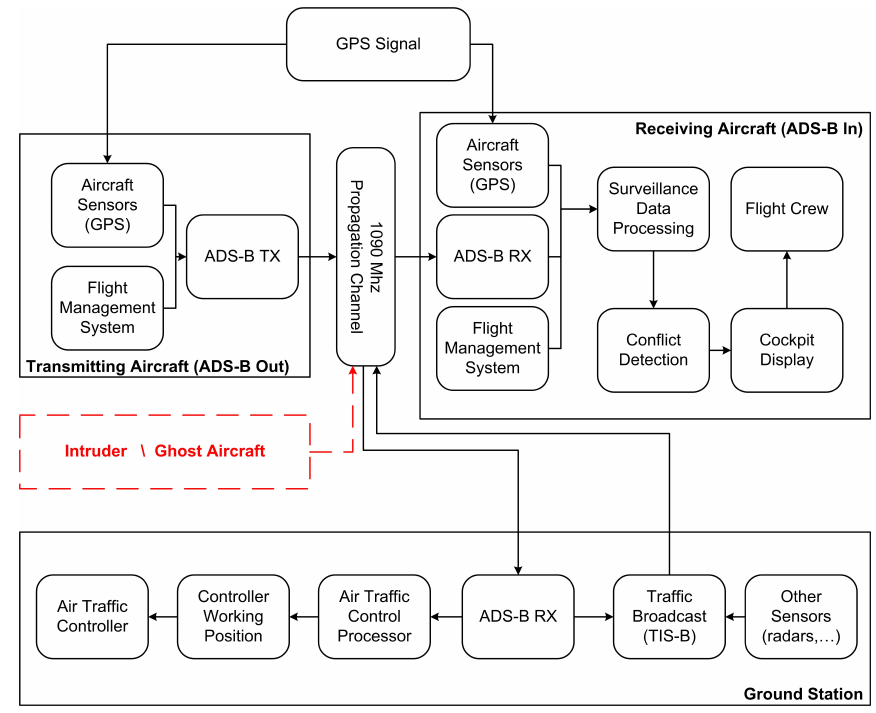
Figure 1. ADS-B operational Block Diagram. A possible intruder who is sending fake messages is also represented.